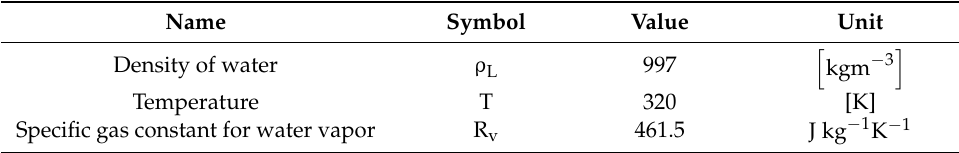
Table 2. Physical parameters.